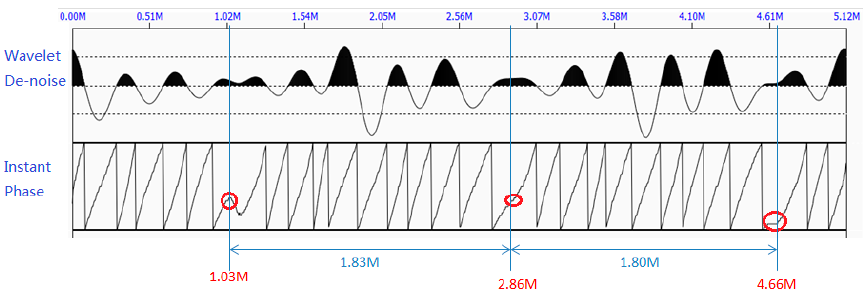
Figure 8. The denoised waveform by wavelet denoising algorithm ( top ) and the periodic pattern of the instant phase ( bottom ).